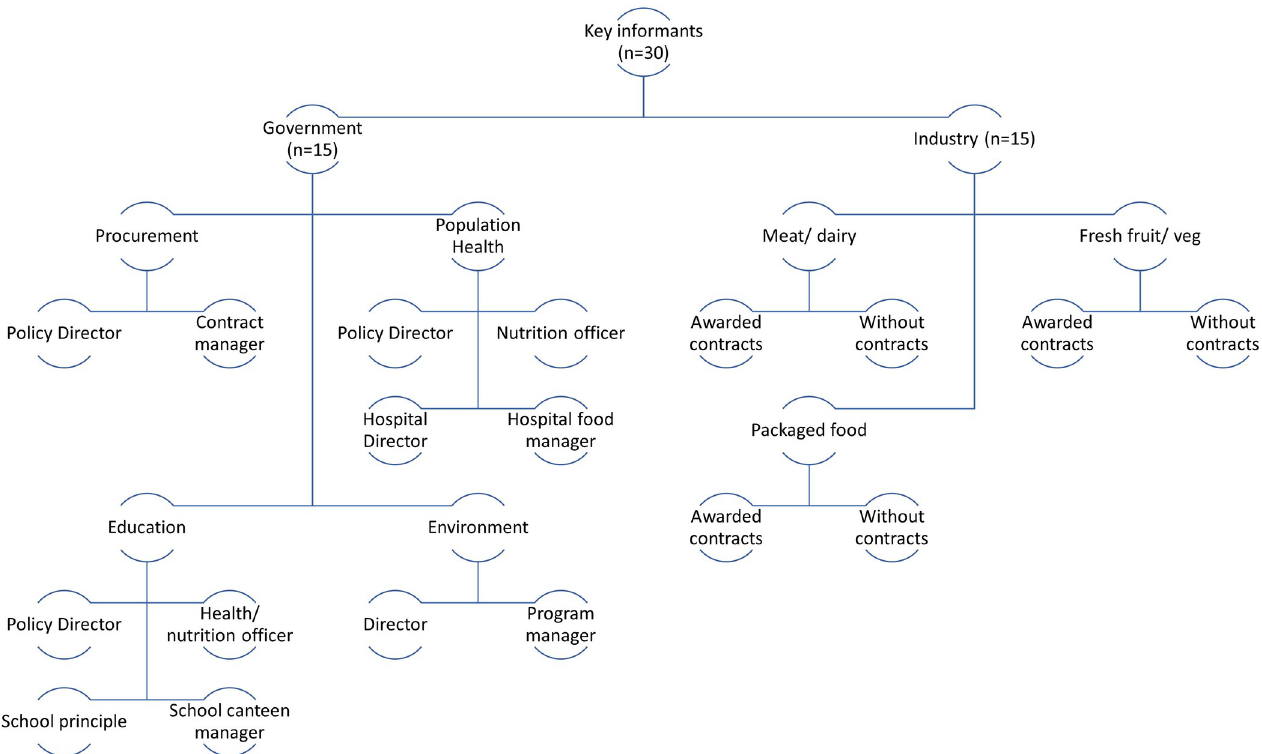
Fig 3. Sampling framework for government food